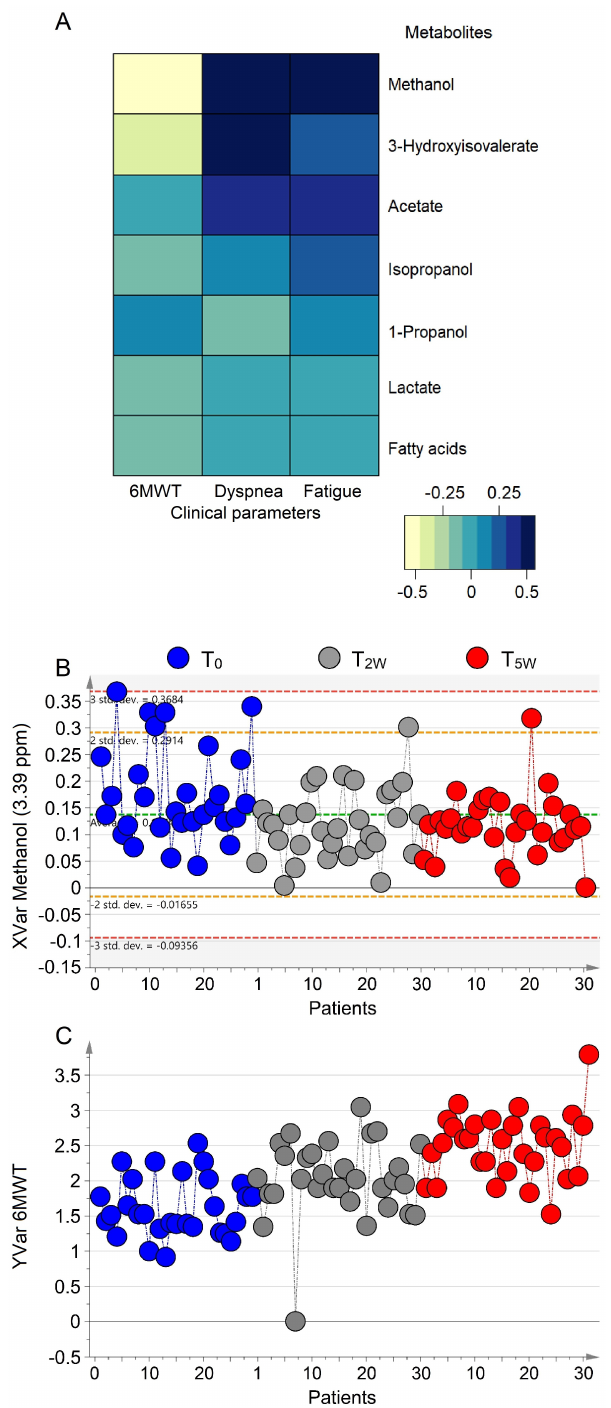
Figure 5. Correlation between molecular and clinical parameters. ( A ) Heatmap based on Pearson correlation coefficients between metabolites and clinical data. ( B ) Decrease of methanol values during the PR 5-week program at T 0 (blue dots), T 2W (gray dots), and T 5W (red dots). ( C ) Corresponding increase of the distance in the 6MWT. In ( A ), blue tone indicates positive correlations between NMR and clinical parameters, whereas light tones indicate negative correlations. The strongest correlations are for methanol (see text). ( B ) XVar (methanol) and ( C ) Yvar (6MWT) show the values for the “molecular response” and distance variations during PR. Numbers on the x -axis refer to EBC samples of COPD patients involved in the study; the y -axis reports the